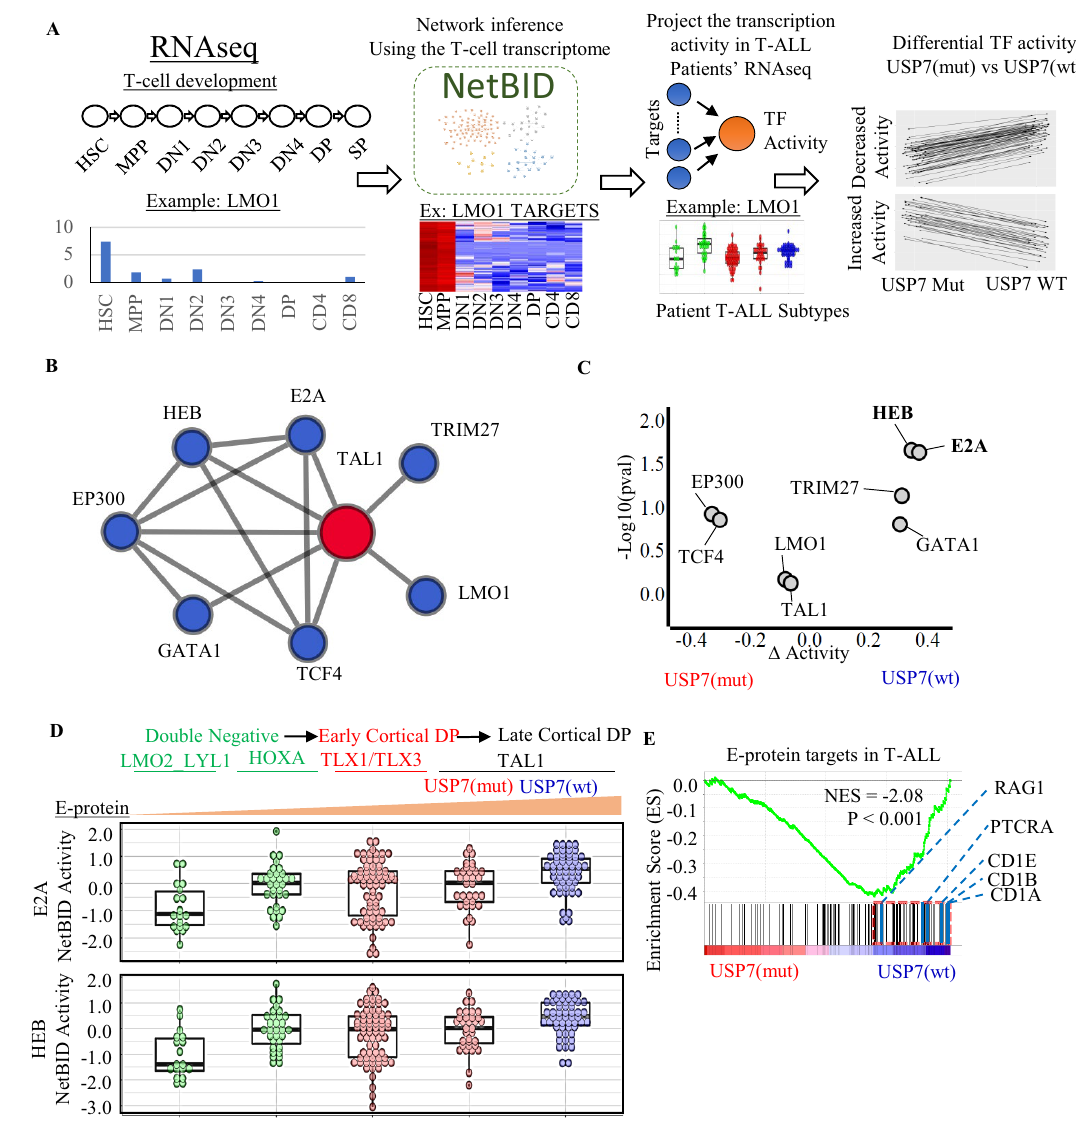
Figure 2. USP7 haploinsufficiency reduces E-protein activity in NCI TARGET T-ALL cohort. ( A ) NetBID network analysis overview. A transcription factor network was generated based on the transcriptome profiling of T-cell development. Transcription factor activity in T-ALL is estimated using their down-stream targets with NetBID. Dysregulated transcription factors are identified for USP7 haploinsufficiency. ( B ) NetBID identified transcription factors that interact with TAL1. The edges represent known physical interaction from STRINGdb. ( C ) Differential activities of TAL1-interacting transcription factors (TF) based on NetBID analysis. The x-axis presents the change in TF activity between USP7 wt and USP7 mut TAL1 T-ALL samples, and the y-axis presents the p-values (− log10) by an unpaired two-sided t test. ( D ) E2A and HEB activities across the major T-ALL subgroups. ( E ) Enrichment of E-protein targets in USP7 wt compared to USP7 mut by GSEA analysis. Leading- edge genes are marked by a dotted red rectangle, and the list on the right shows top hit